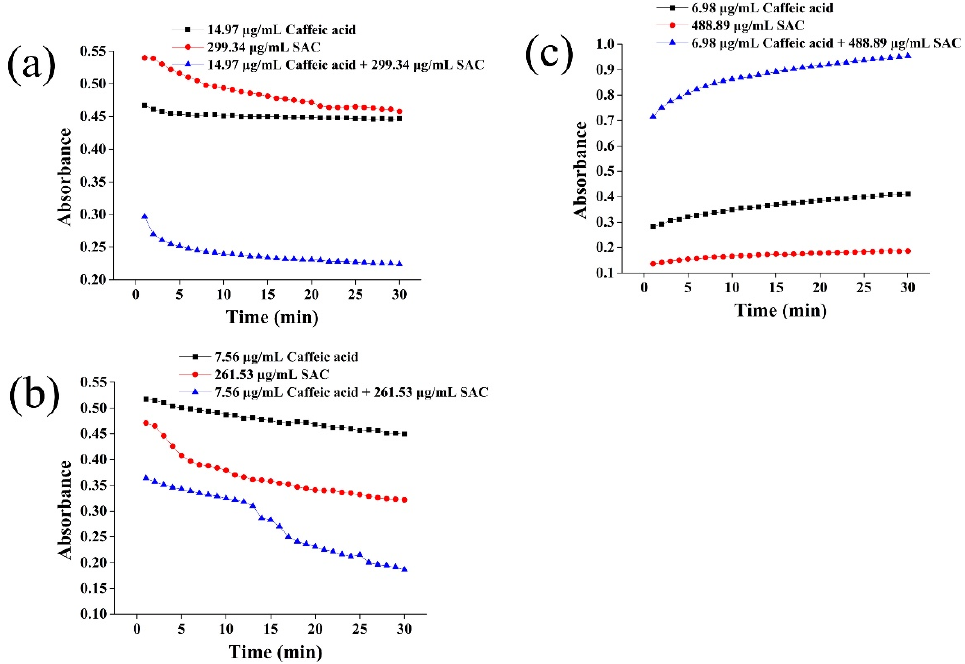
Figure 4. The kinetic curves of scavenged DPPH free radicals, ABTS radical cations, and reducing power by caffeic acid, SAC, and their mixture. ( a ) DPPH assay, ( b ) ABTS assay, ( c ) reducing power assay.